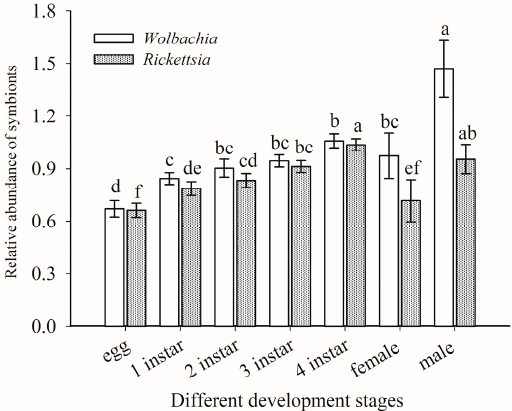
Figure 7. Relative abundance of Wolbachia and Rickettsia in different life stages of B. tabaci Asia II 1. n = 3 biological replicates. The column and error bars represent the fold change in mean ± SE. Means marked with different letters are significantly different from each other ( p ≤ 0.05).